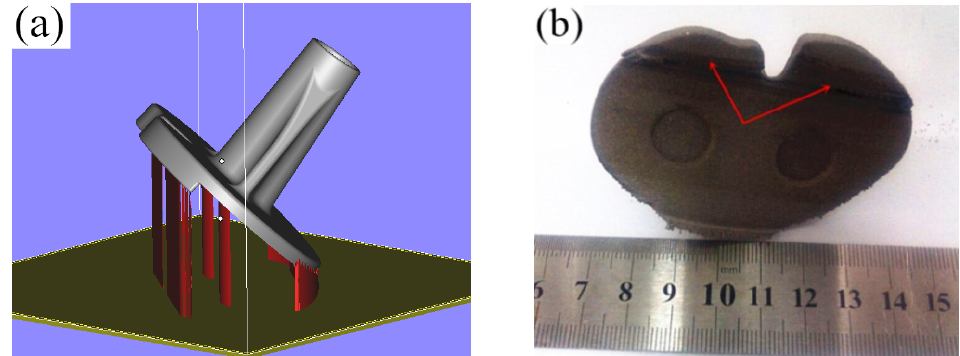
Figure 7. The addition way of the tibial prosthesis support and the effect of SLM molding: ( a ) Conventional tilting 45-degree conventional placement; ( b ) Post forming effect of SLM.